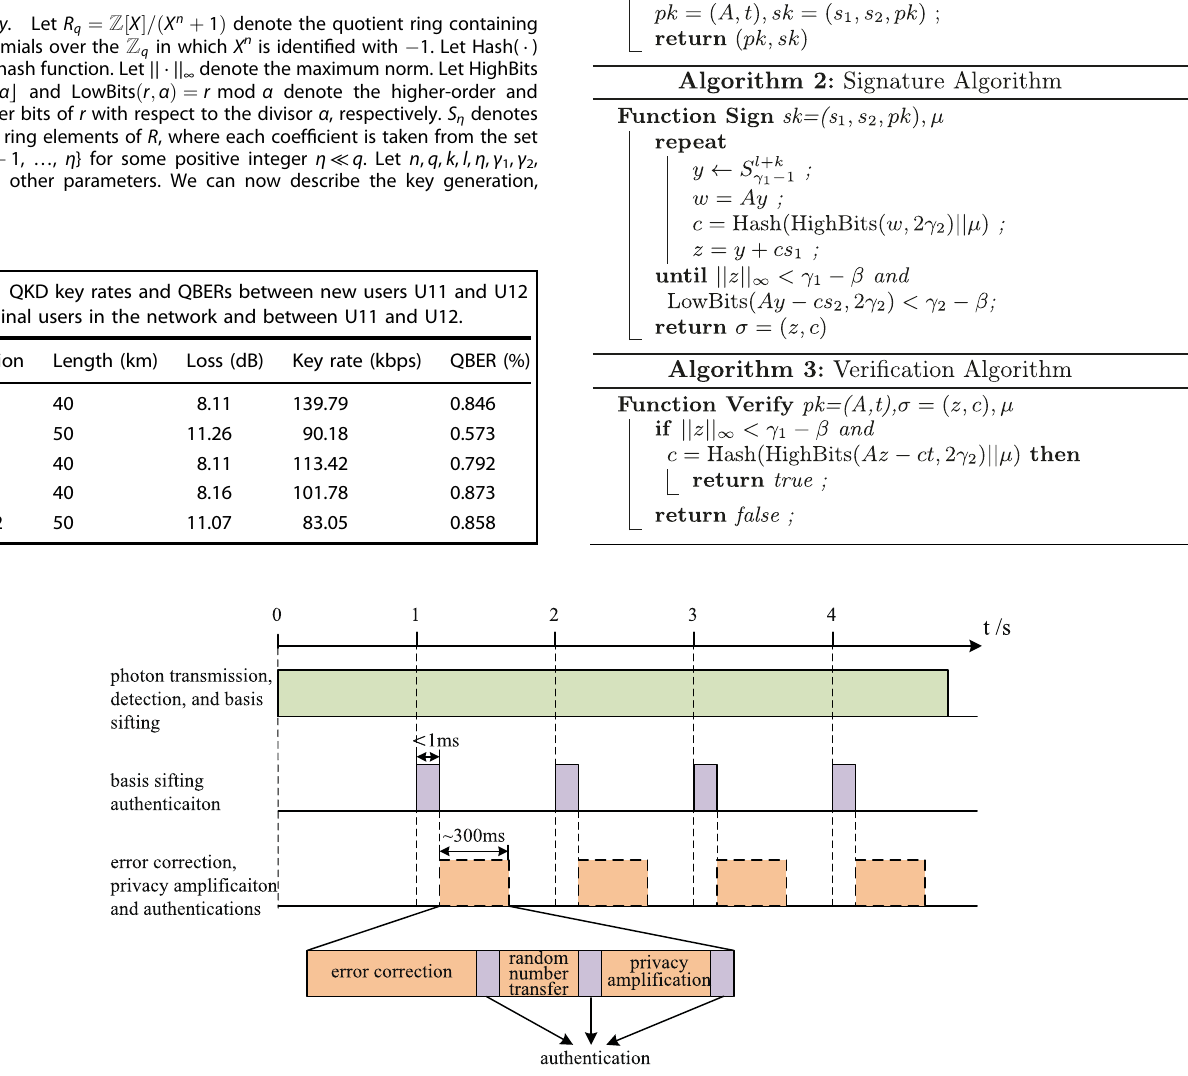
Fig. 4 Timing diagram of the sequence and durations of the authentication and QKD processes. The basis sifting authentication was performed once per second after basis sifting, followed by error correction, privacy ampli fi cation and the corresponding authentication processes. Each authentication process was executed within 1 ms.